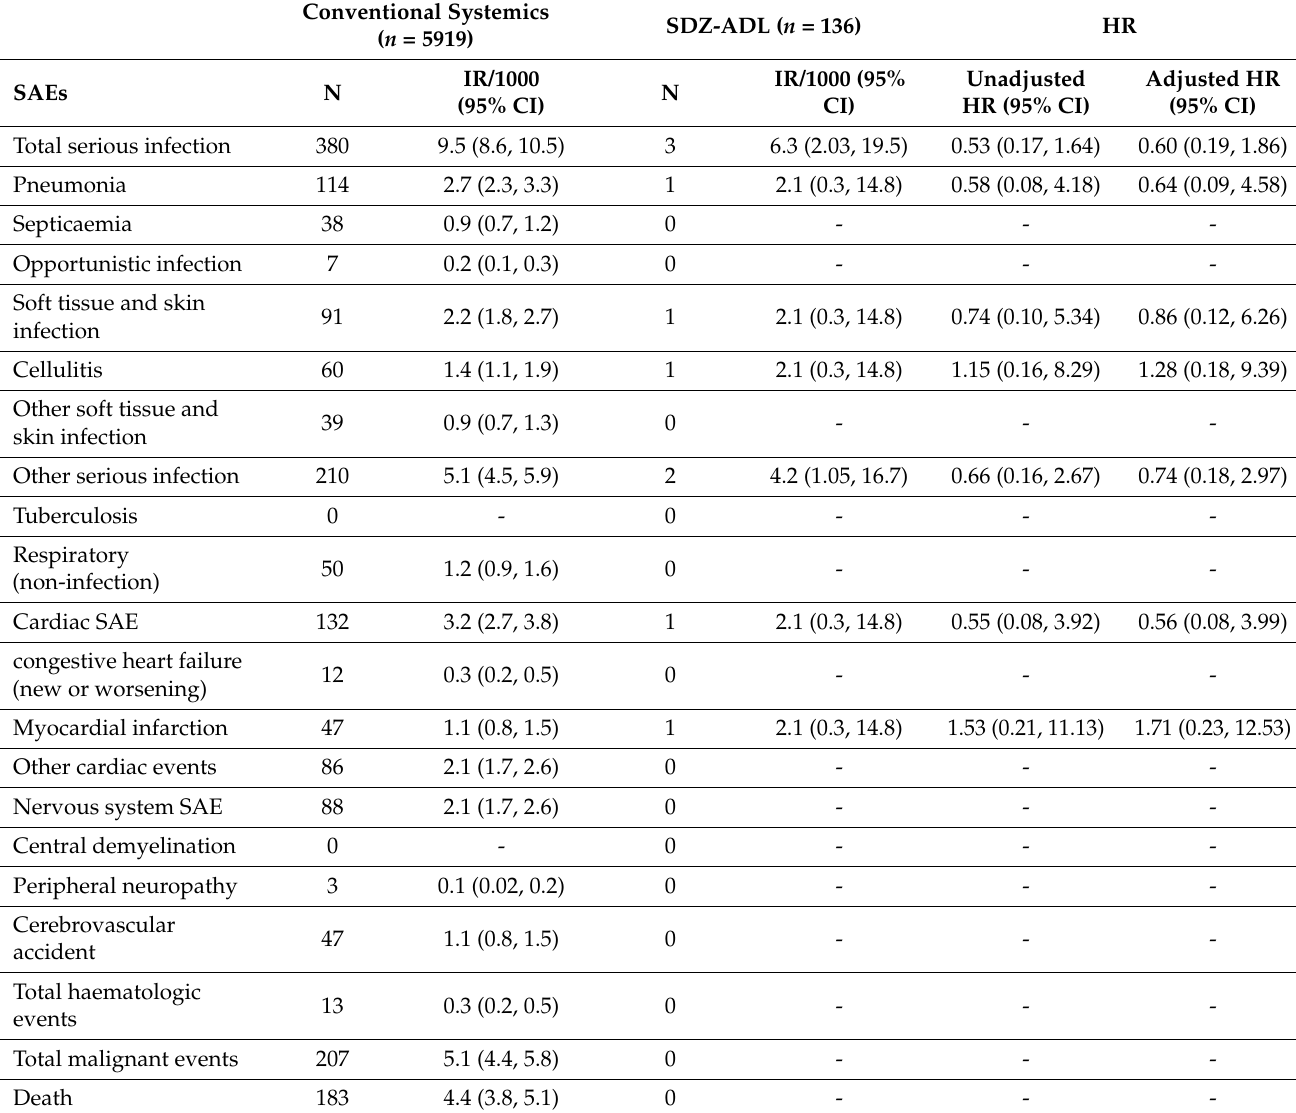
Table 4. Number and rates of first events, including unadjusted and adjusted hazard ratios per 1000 person years in the safety